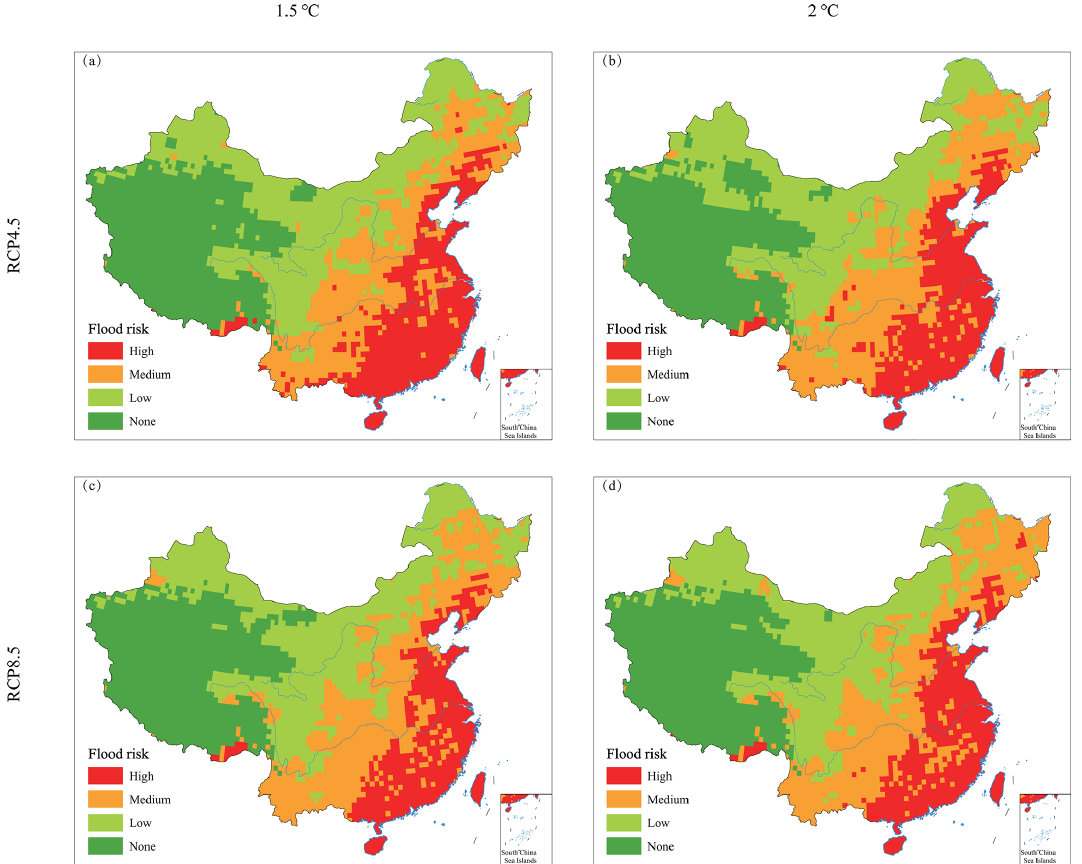
Figure 7. Spatial patterns of the integrated risks posed by floods for 1.5 ◦ C (a, c) and 2 ◦ C (b, d) of global warming under the RCP4.5 (a, b) and RCP8.5 (c, d)